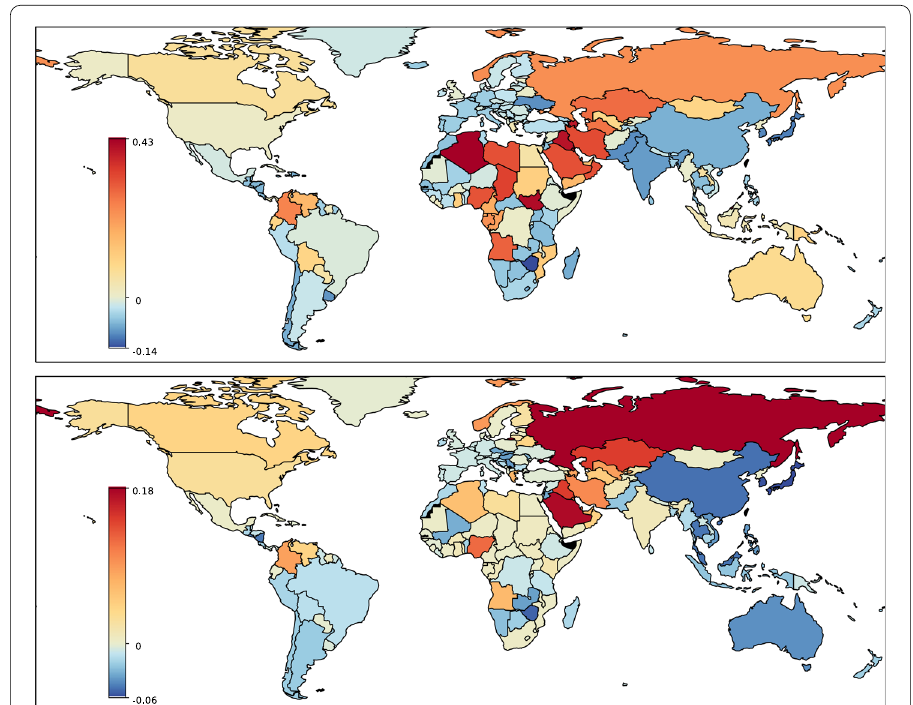
Fig. 3 Sensitivity of country balance. Sensitivity of country balance dB c / d δ s for product s = 3 (mineral fuels). Top panel: probabilities are computed from the trade volume of Export–Import. Bottom panel: probabilities are computed from PageRank and CheiRank vectors. Sensitivity are marked by color with the corresponding color bar ( j ). Data are shown for year